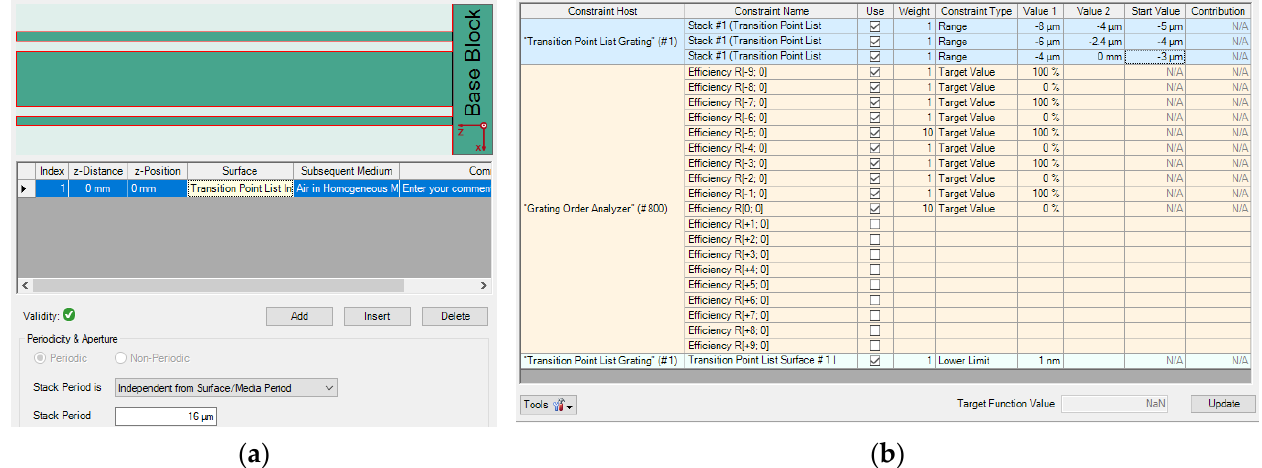
Figure 27. Optimized AH53. ( a ) Initial structure; ( b ) objective functions.